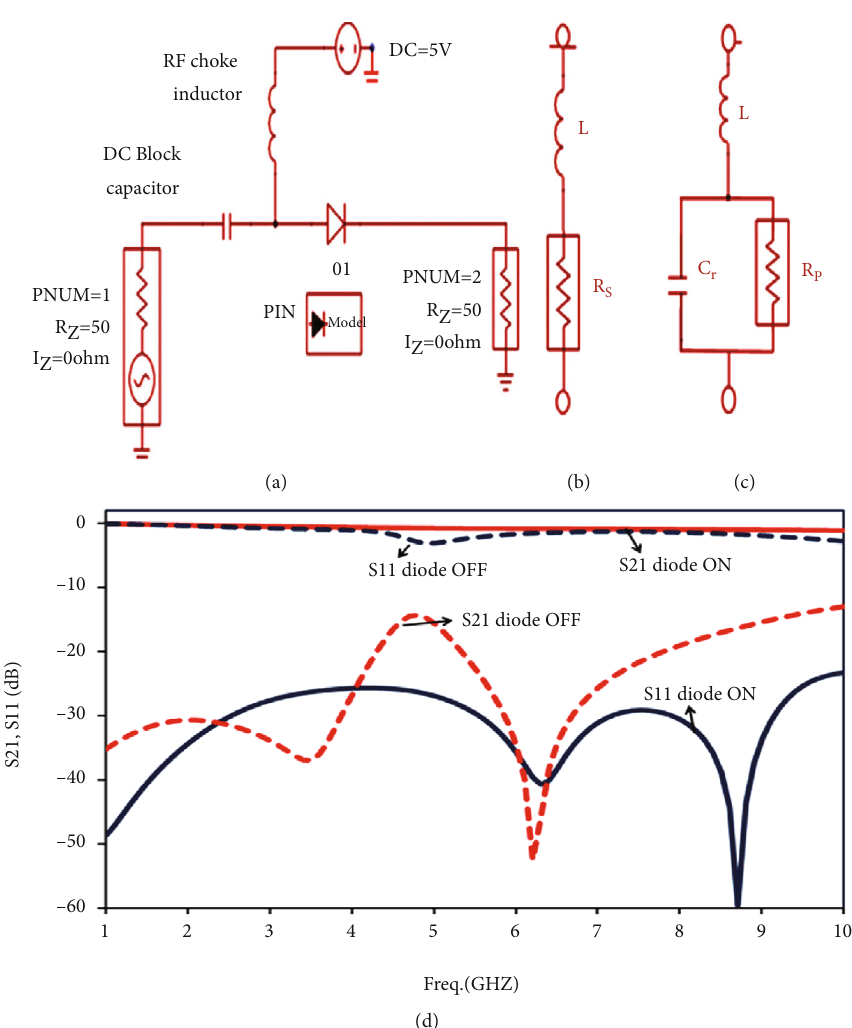
Figure 5: (a) The biasing circuit; (b, c) equivalent model in ON and OFF states; (d) S parameter vs. Figure 7(c) and 7(d). Simulated value of S is 0.5dB from 1 – 21 7GHz whereas measured value is 0.2dB from 1 – 7GHz.